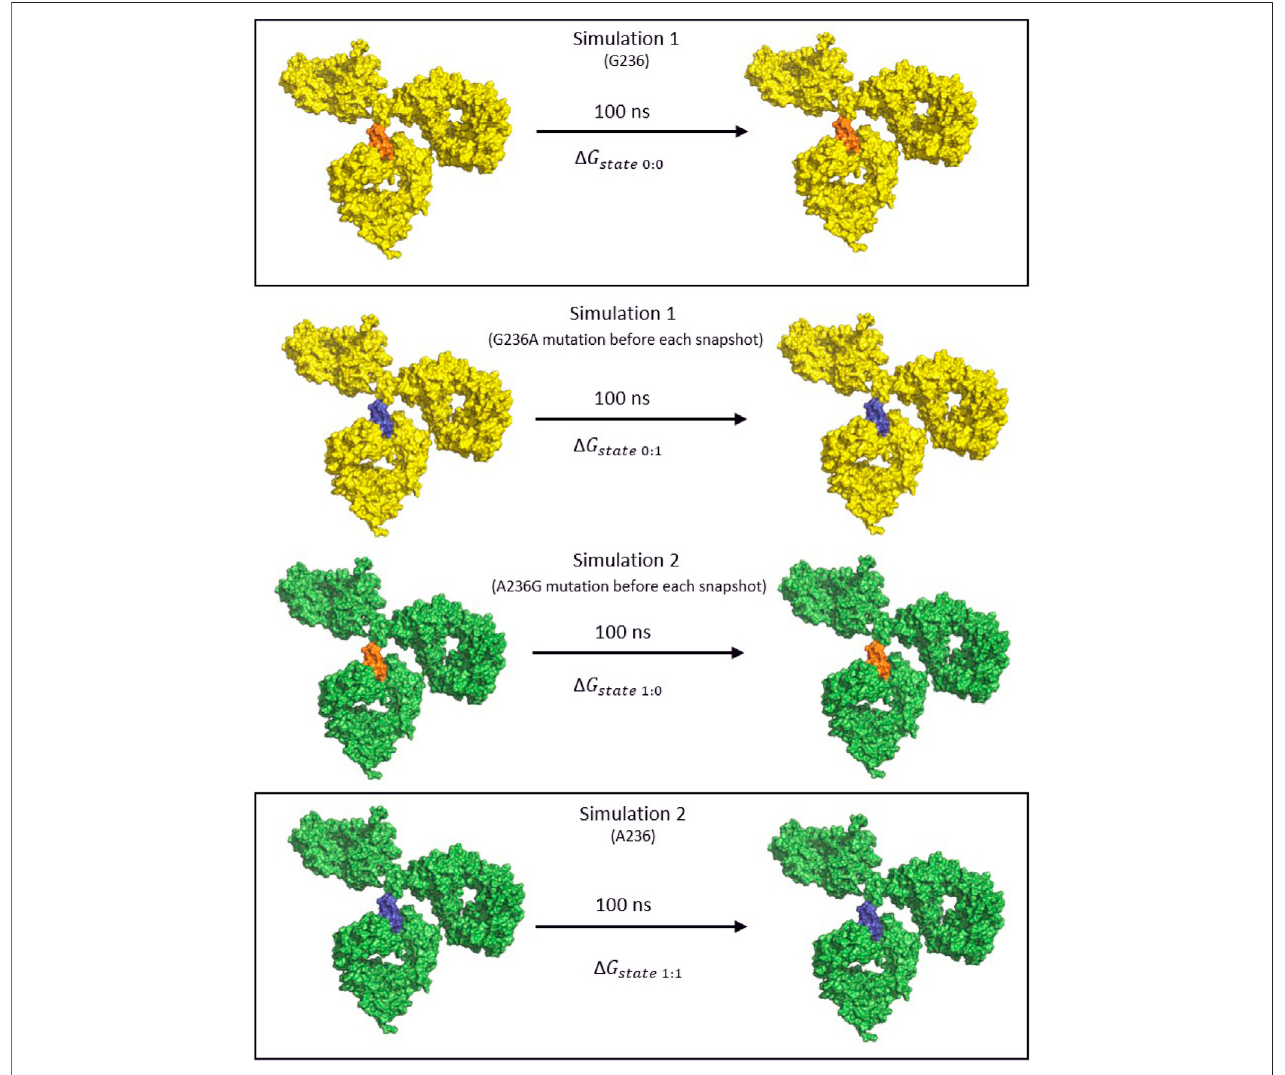
FIGURE 4 | The thermodynamic cycle for the calculation of the binding free energy using the BAR method. The IgG1 antibody is colored yellow for the fi rst simulation and green for the second, the Gly236 variant is orange and the mutated Ala236 is blue. Two simulations were performed for each of the Fc γ R bound to the antibody. Subsequently, the intermediate trajectories 0 → 1 and 1 → 0 were obtained by mutating the original amino acid of the given simulation at every snapshot of the simulation before calculating the free energy terms.